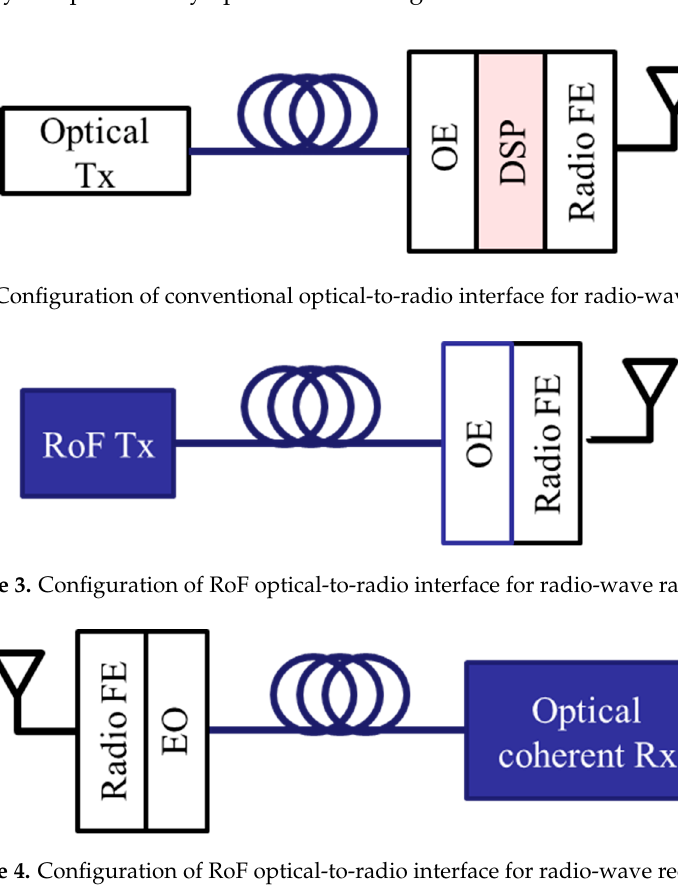
Figure 4. Configuration of RoF optical-to-radio interface for radio-wave reception.